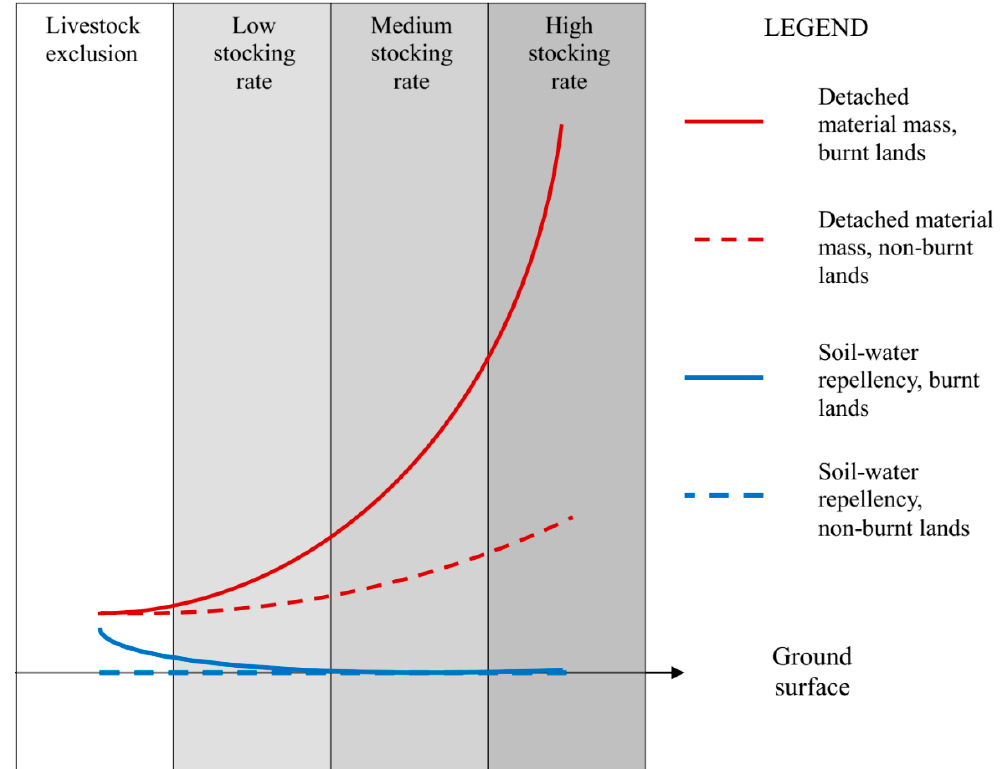
Figure 3. Conceptual illustration of the impacts of stocking rate on detached material mass and soil-water repellency, under burnt and non-burnt lands. Notes: Livestock hoof action shears the uppermost soil layer, with the resultant detachment of mineral material. Elevated stocking rates increases this process. In fire-prone lands, the reduced aggregate stability of soil enables the acceleration of soil shearing and detachment. At the same time, the fire-derived water repellency of the uppermost soil layer is negated by the animal hoof action, which shears the ‘baked’ ground surface. Modified from Stavi et al. [83].